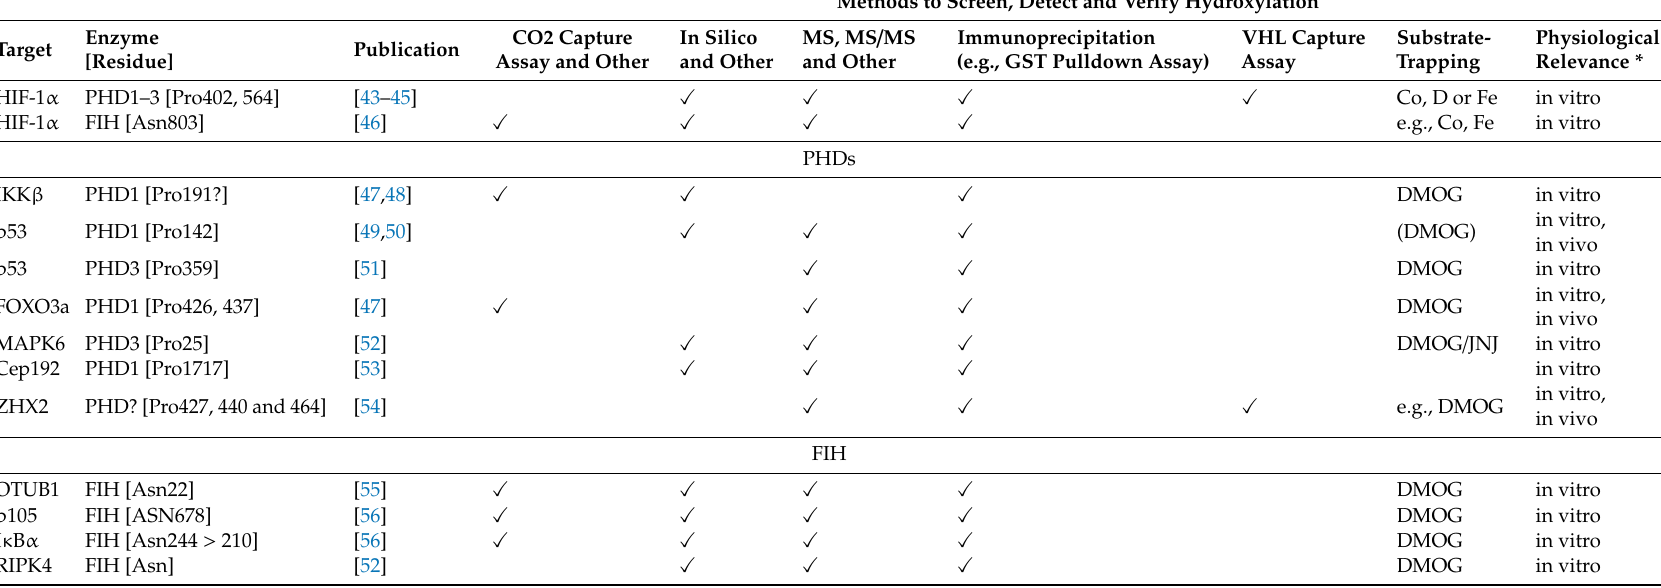
Asn asparagine, Cep centrosomal protein, Co cobalt (II), D desferrioxamine, Fe Iron (II), DMOG dimethyloxaloylglycine, FOXO3a forkhead box O3a, GST glutathione S-transferase, HIF hypoxia-inducible factor, IKK β I κ B kinase- β , JNJ JNJ-42041935, MAPK6 mitogen-activated protein kinase 6, MS mass spectrometry, MS / MS tandem mass spectrometry, OTUB1 ovarian tumor domain containing ubiquitin aldehyde binding protein 1, PHD HIF-prolyl hydroxylases, p105 NF- κ B precursor (NFKB1), p53 tumor suppressor protein 53, Pro proline, RIPK4 receptor interacting serine / threonine kinase 4, ZHX2 zinc fingers and homeoboxes 2. * Physiological relevance refers to the applied experimental design (in vitro–cell culture experiments versus in vivo–animal studies involved) upon first